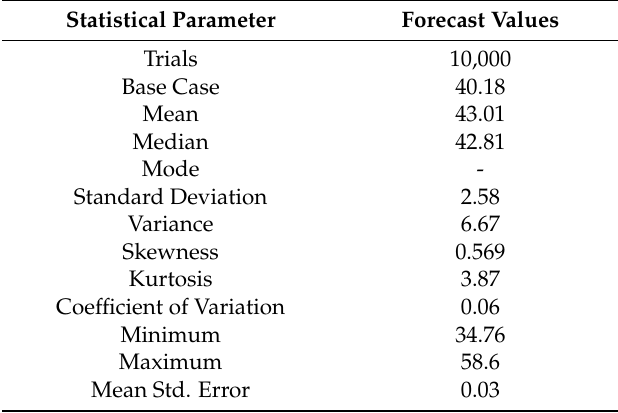
Figure 4. Certainty of 40.18 MTOE for energy consumption for 2012–2013. Table 2. Statistical parameters of total energy consumption